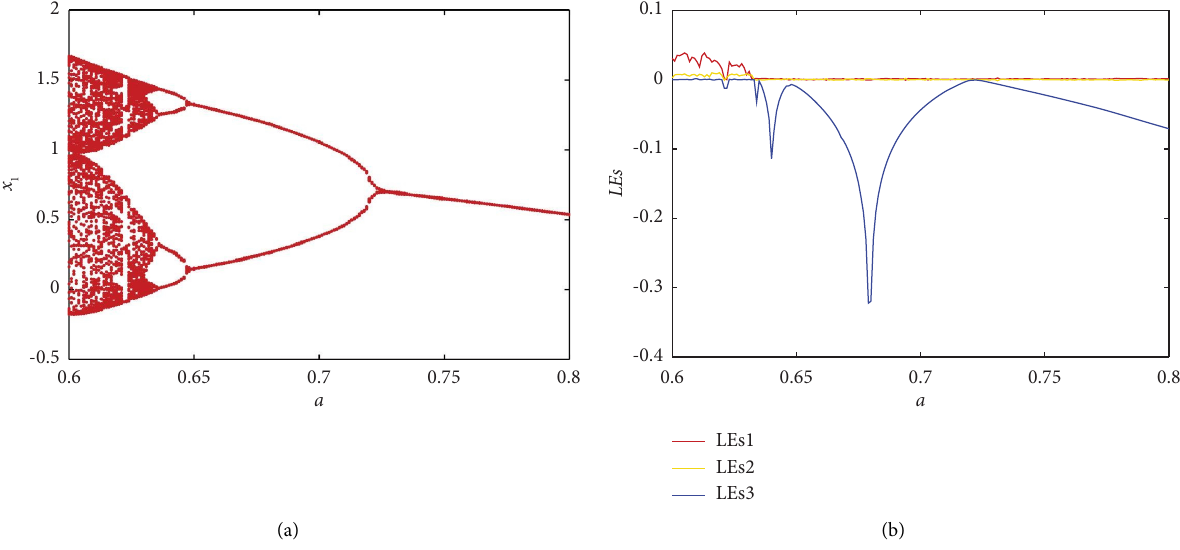
− x − x plane phase diagram; (b) power spectrum. 1 2 3